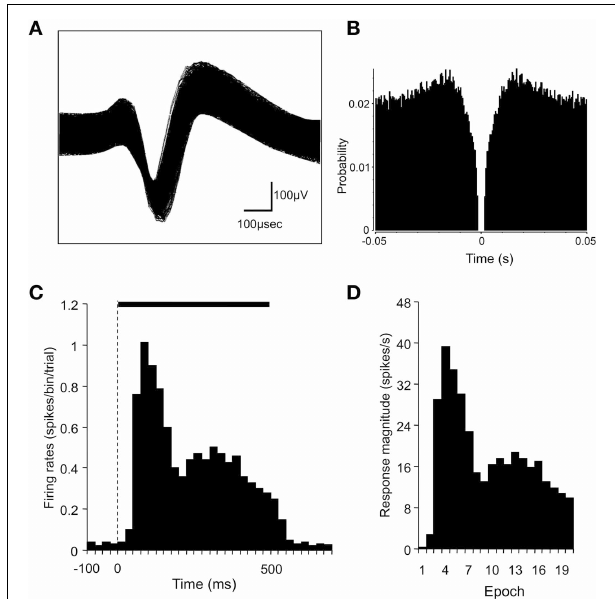
FIGURE 3 | Identification of superior colliculus (SC) neurons and the analysis of SC neuronal responses. (A) An example of superimposed traces of a SC neuron. (B) Autocorrelograms of the neurons indicated in (A) . Bin width, 1ms. The ordinate indicates probability where bin counts were divided by the number of spikes in the spike train. (C) A perievent histogram of the neuron indicated in (A) , showing responses to a visual stimulus. Bin width, 25ms. The dashed line indicates the onset of stimulus presentation, and the horizontal bar indicates the duration of the stimulus (500ms). (D) Magnitudes of the SC neuronal responses indicated in (C) . The stimulus duration was divided into 20 epochs (25ms each). The response magnitudes (spikes/s) were defined as follows: the mean firing rate in each epoch minus the mean firing rate during the 100-ms period before stimulus